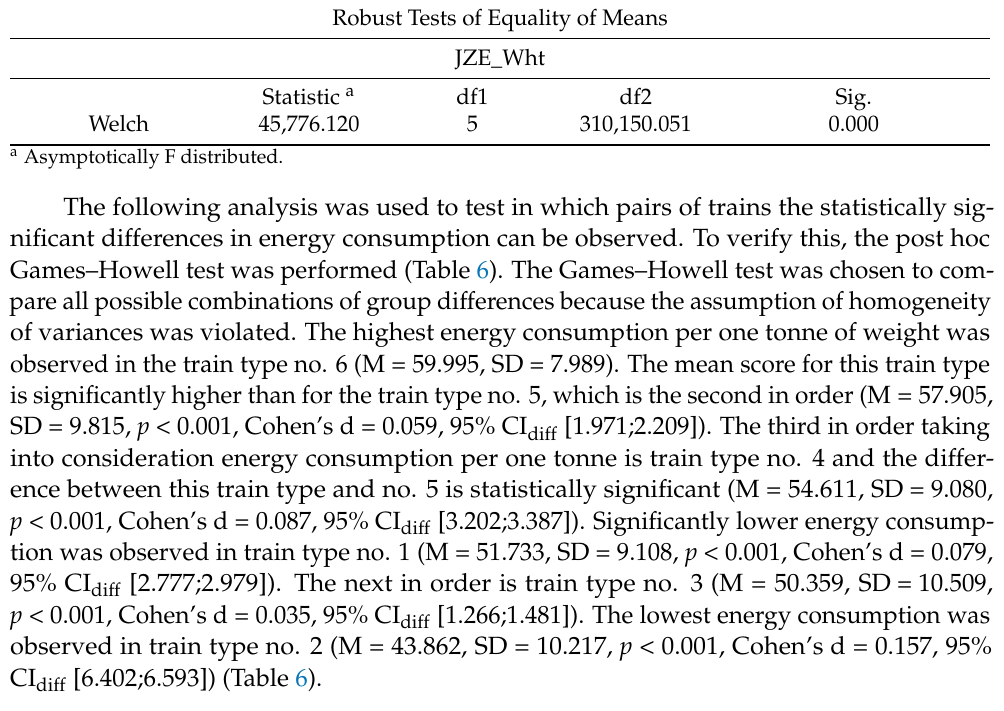
Table 6. The results of Games–Howell